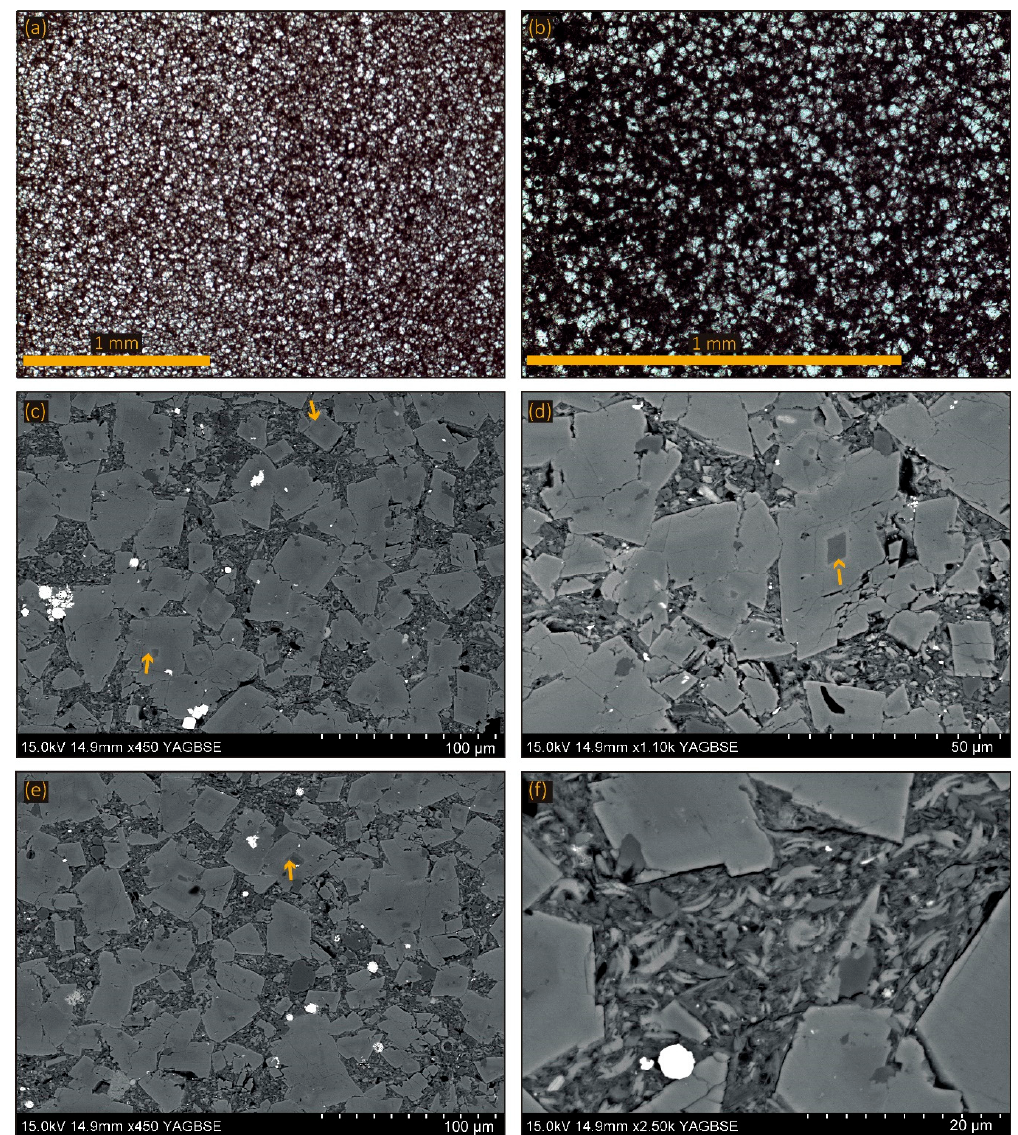
Figure 8. Facies 6: Carbonate cemented, fine to medium mudstone composed of calcium and magnesium carbonate (dolomite) crystals in a clay-rich matrix ( a , b ) Optical micrographs of carbonate cemented, coarse grained mudstone. ( c – f ) Backscattered electron photomicrographs. Yellow arrows point to zonation within dolomite crystals. Note the relict matrix composed of clay minerals and coccolith debris. Note the presence of pyrite (bright white components) within both the matrix and